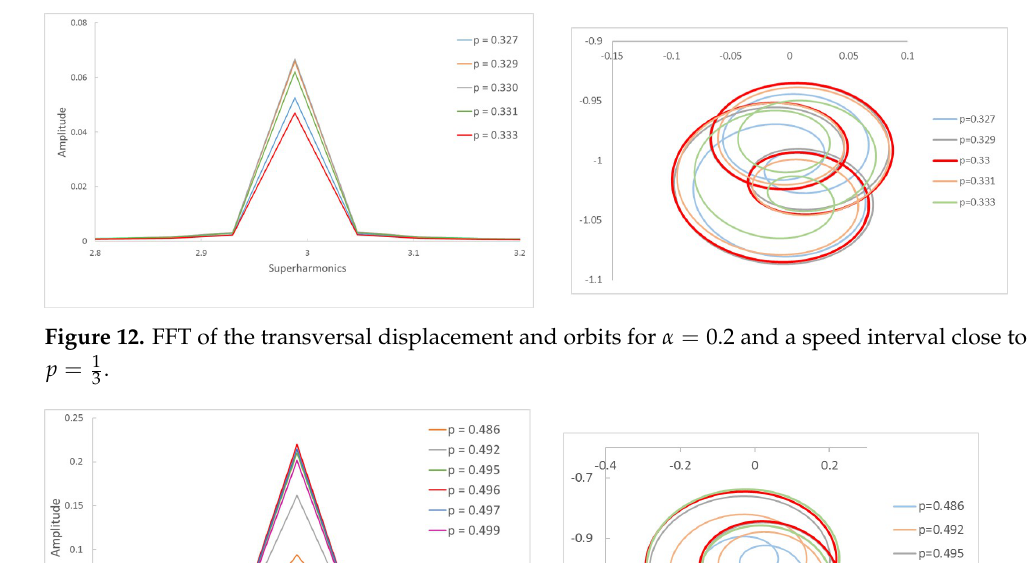
Figure 11. Orbits of the shaft for α = 0.45 within a speed interval close to p = 1 p = 0.484.